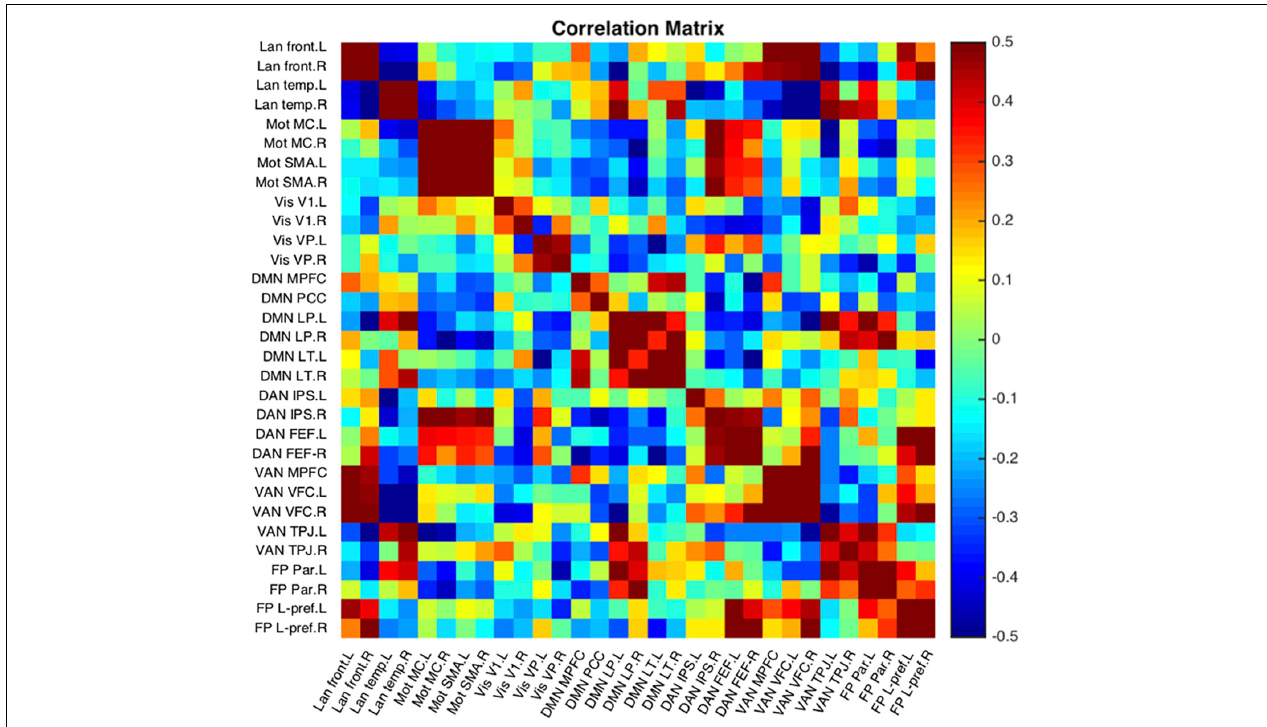
FIGURE 12 | Representative subject resting state network example seed-to-seed functional connectivity correlations.